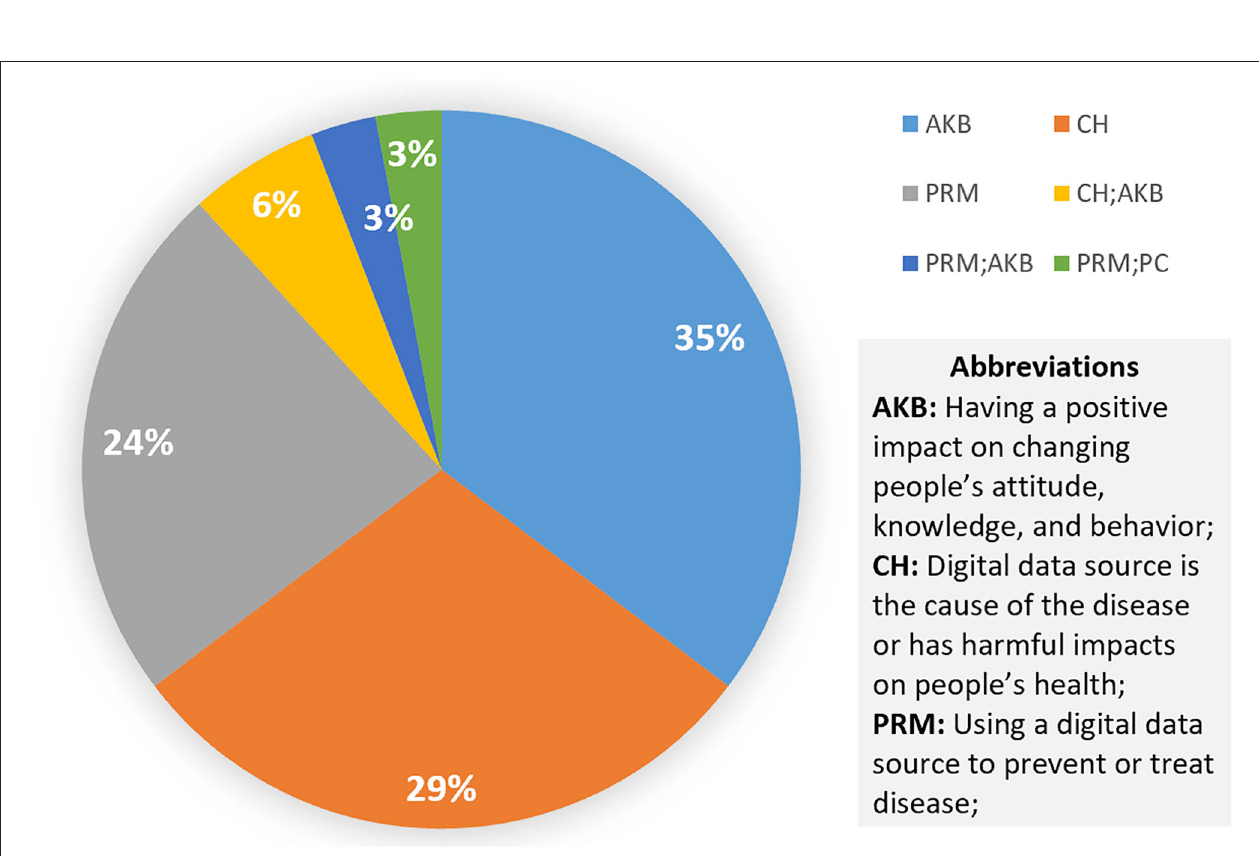
FIGURE 9 | Pie chart showing the impact of digital data sources on healthier populations.